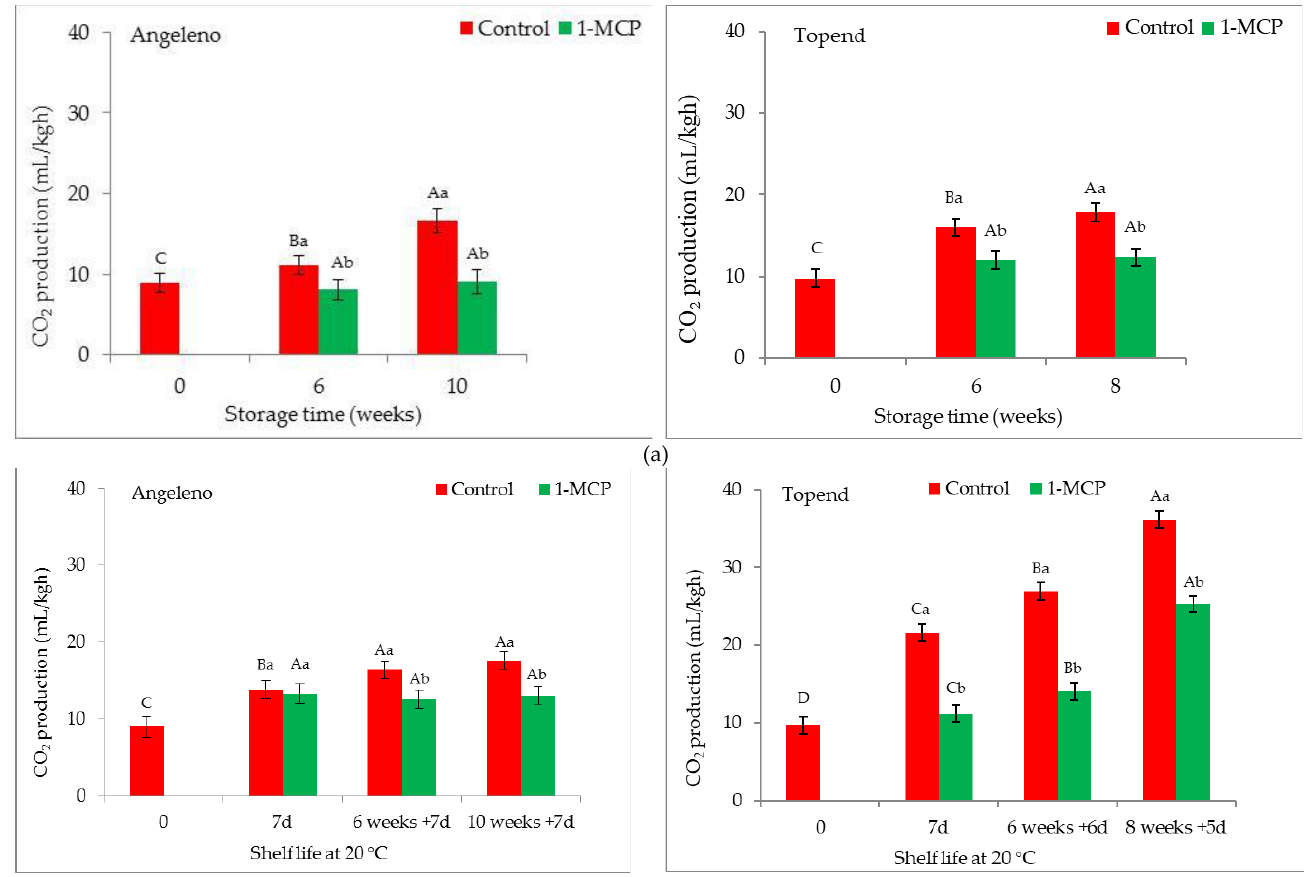
Figure 2. CO 2 production of plum after cold storage at 1 °C ( a ) and subsequent shelf-life storage at 20 °C ( b ). Presented values are mean ± SD. Upper case is for the comparisons of time (Tukey’s, p < 0.05). Lower case is for the comparisons of treatment (Tukey’s, p < 0.05).